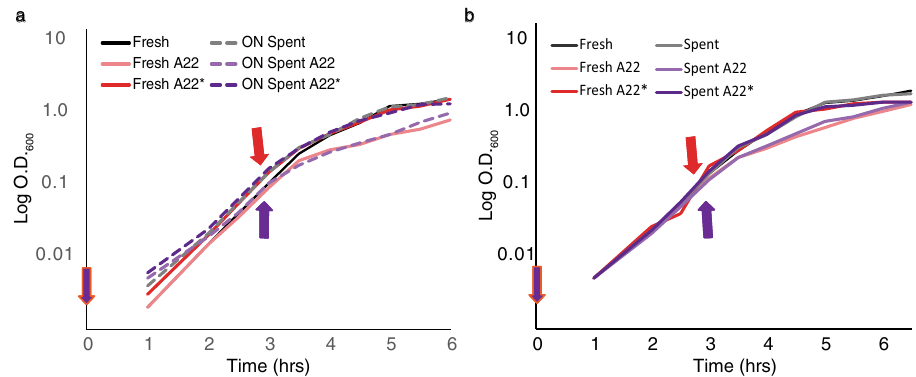
Fig. 3 Changes in media do not cause growth resistance. Arrows are color-coded to the lines representing spike (*) conditions. a Representative growth curve of WT cells grown at 37 °C with 10% spent media from an overnight culture. Cells were grown in LB, A22 (10 μ g/ml), and A22 added at the indicated time where OD 600 ~0.1 (*). b Representative growth curve of WT cells grown at 37 °C with 100% spent media from a culture grown to an OD 600 0.1. Cells were grown in LB, A22 (10 μ g/ml), and A22 added at the indicated time where OD 600 ~0.1